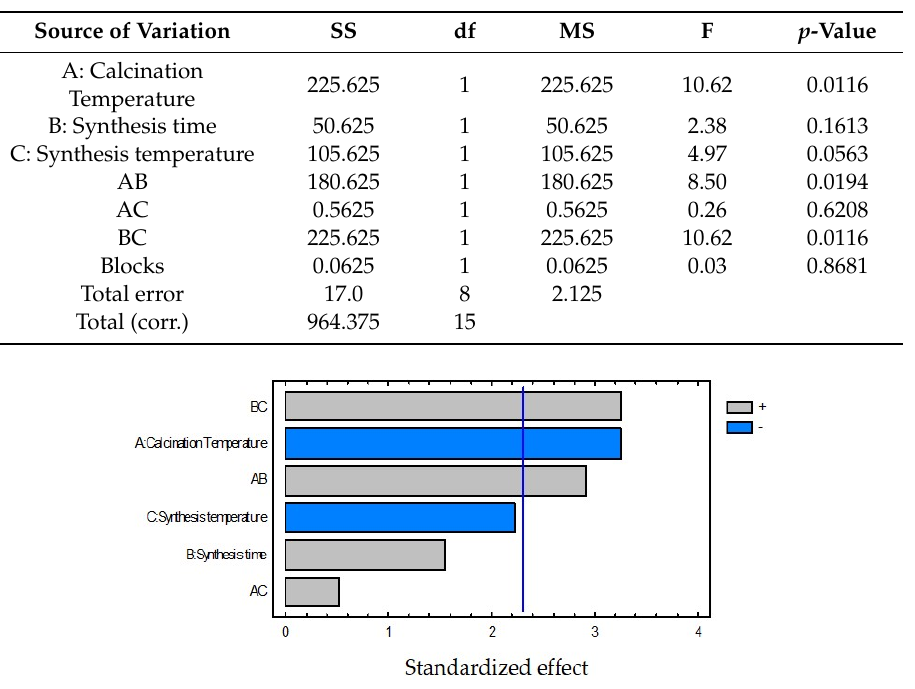
Figure 4. Standardized Pareto Chart for degradation percentage of K 3 [Fe(CN) 6 ].